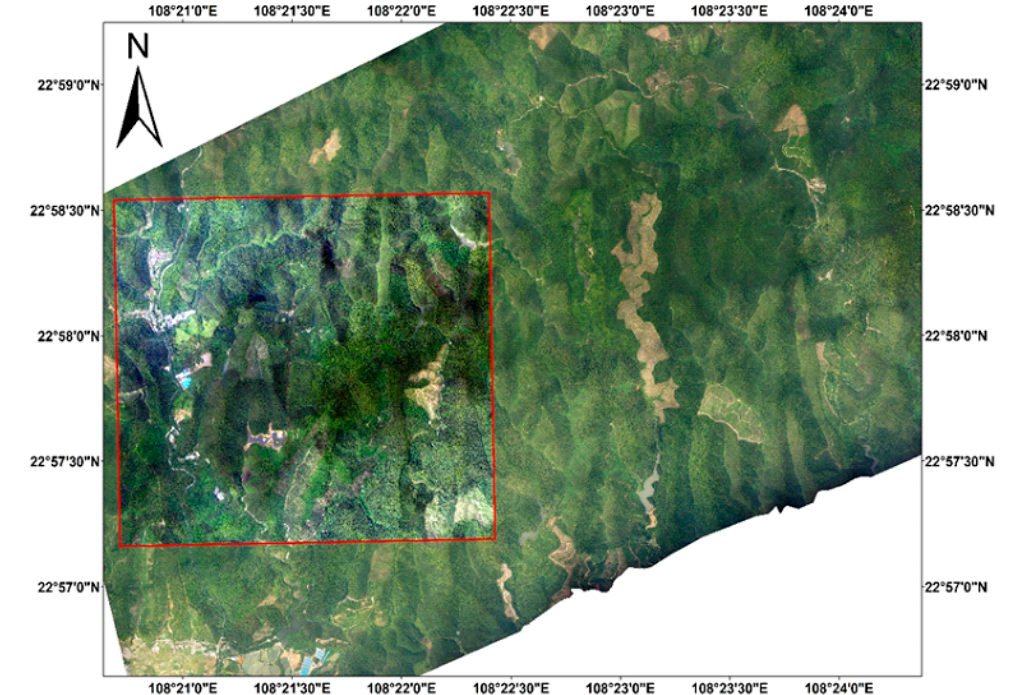
Remote Sens. 2021 , 13 , x FOR PEER REVIEW